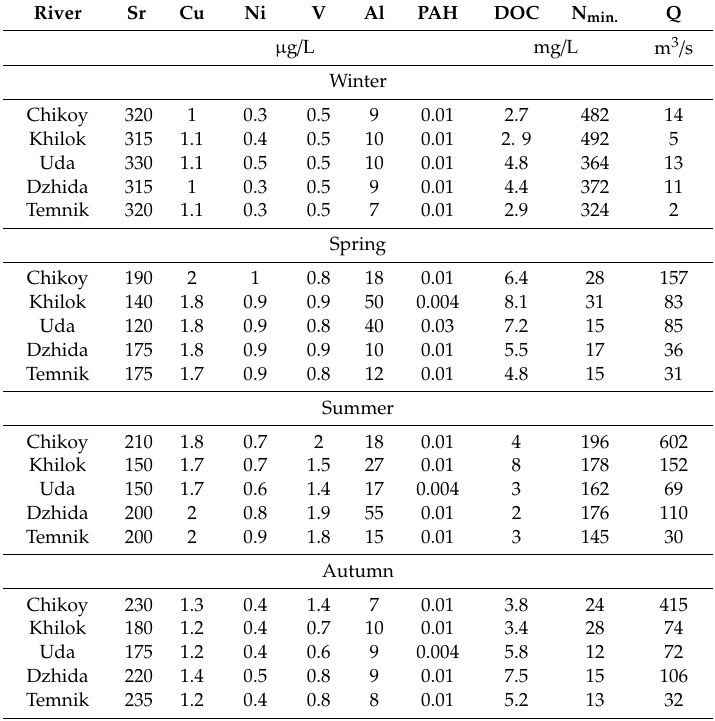
Table 3. Average chemical composition and water discharge of the Selenga